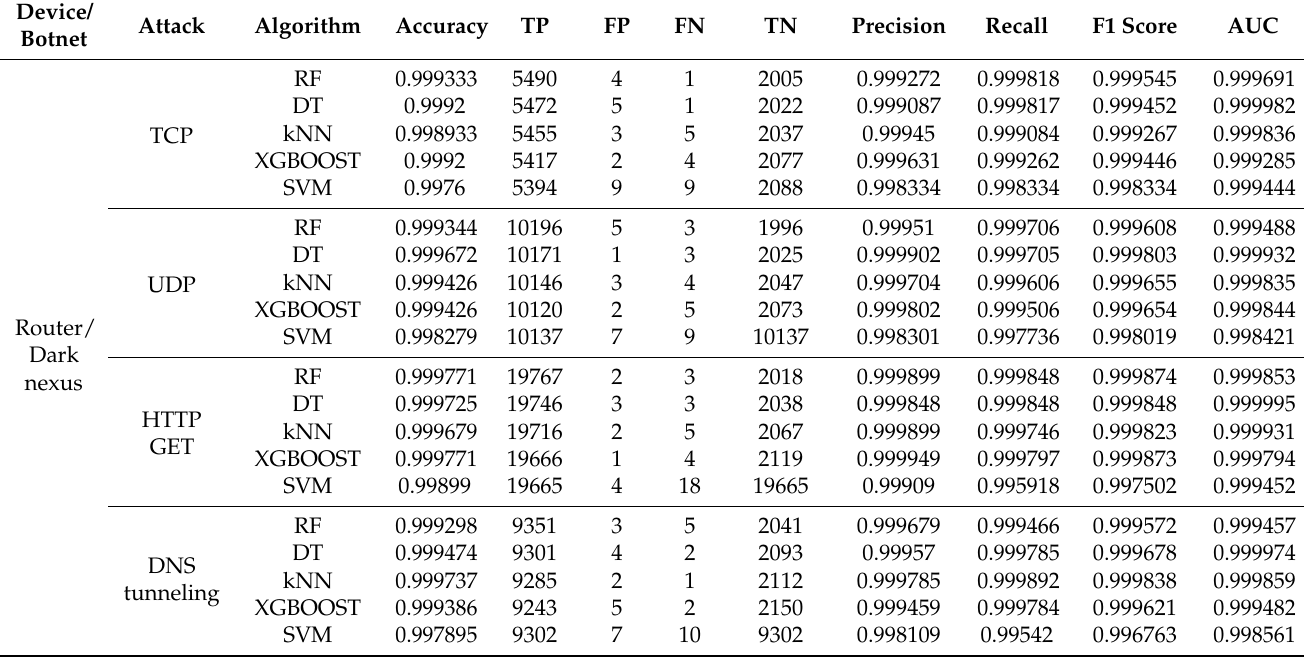
Table 13. Classification results (router—Dark